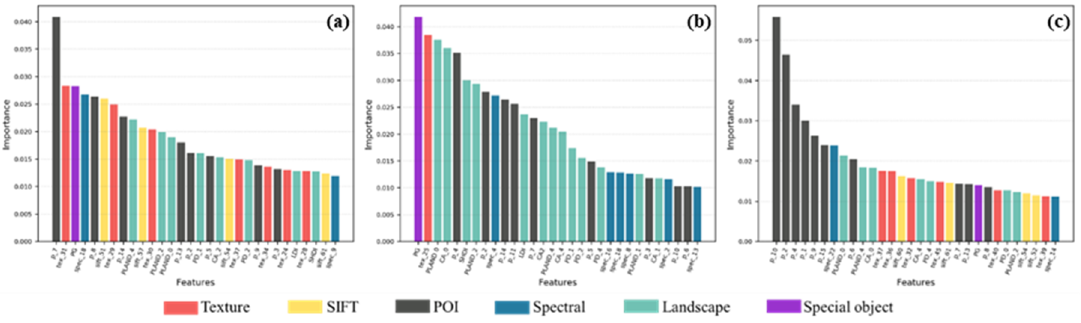
Figure 6. The rank of feature importances (top 30) ( a ) Block, ( b ) Grid and ( c ) Object.